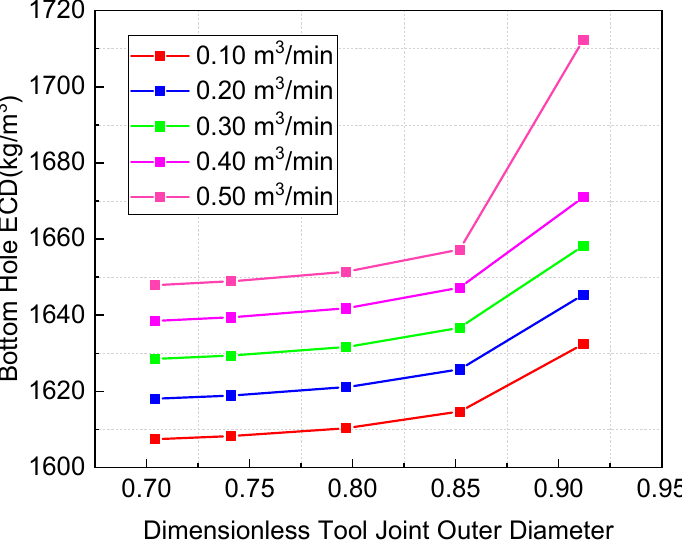
Figure 14. The relationship between the bottom hole ECD and the dimensionless tool joint outer diameter.